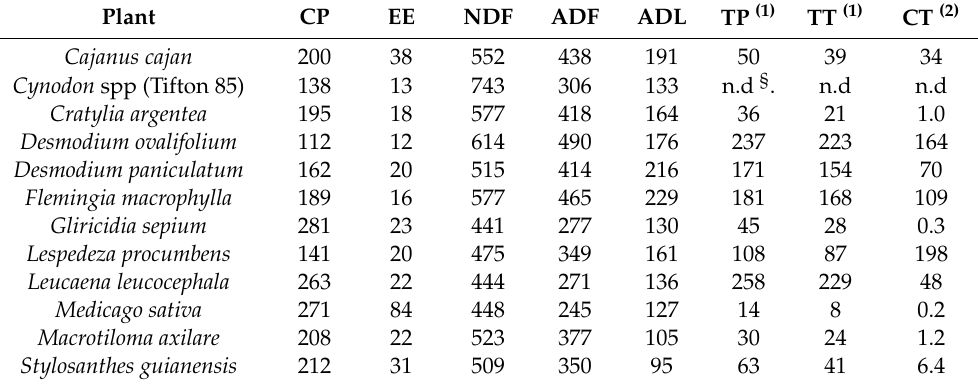
Table 4. Chemical composition of substrates used in the in vitro bioassay (g / kg dry matter (DM)). Plant CP EE NDF